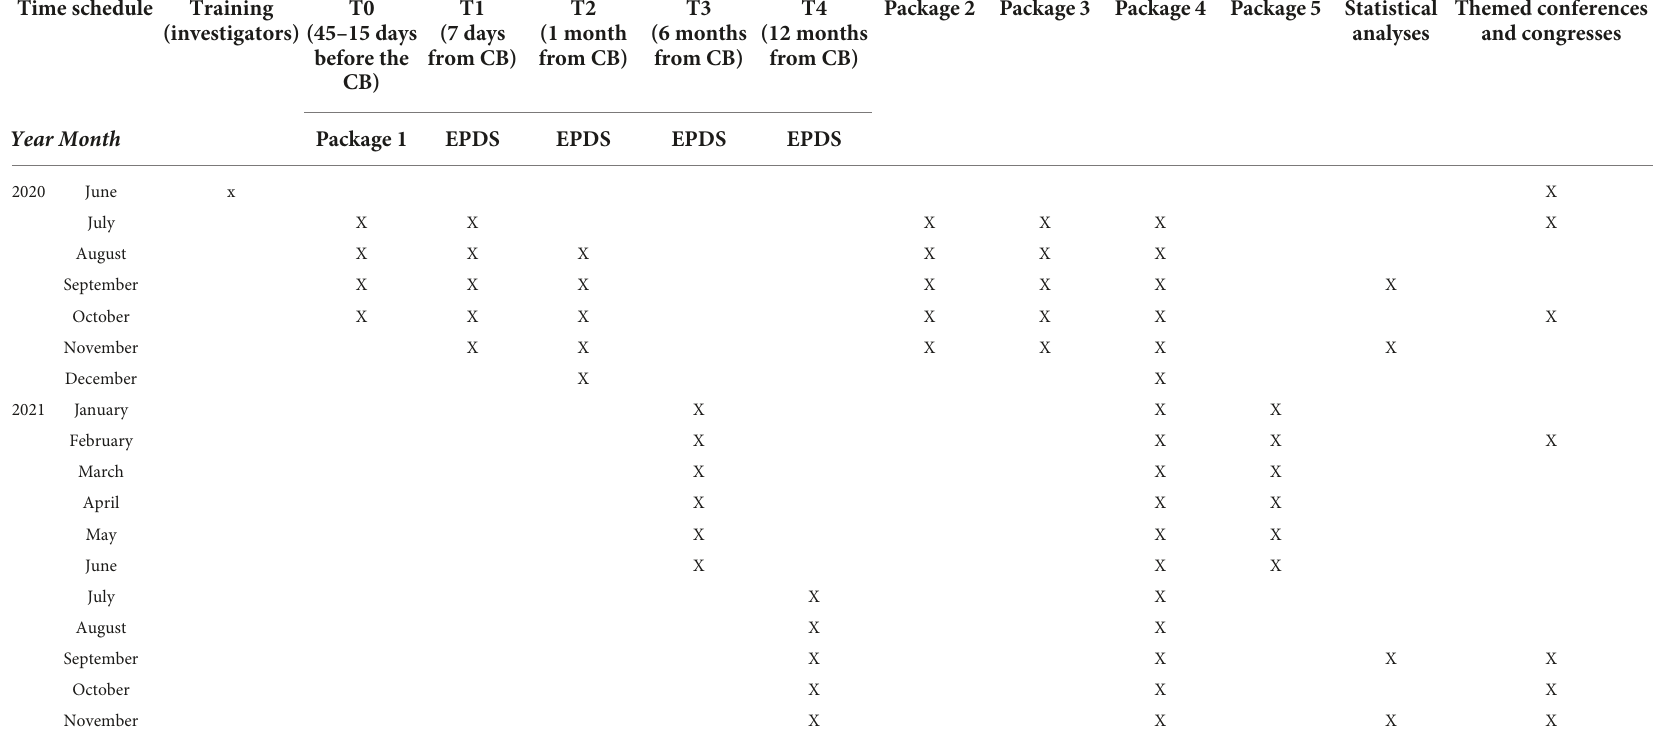
TABLE 1 Study time-schedule and steps (T0-T4). Time